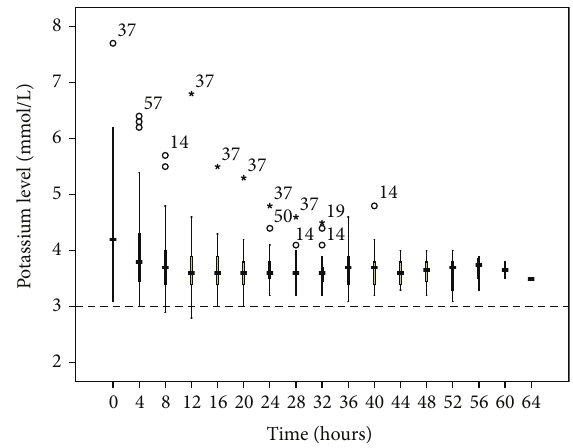
Figure 8: Magnesium changes over time during citrate CRRT. Standard box plot in which the horizontal line represents the median,thethicklinerepresentstheinterquartilerange,andthethin line represents the maximum and minimum values. The circular dots represent the outliers.